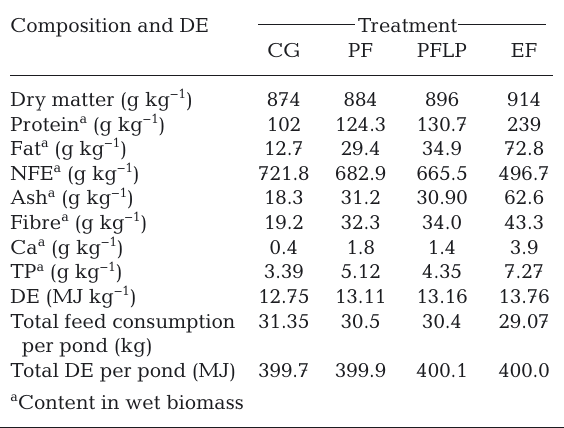
Table 1. Chemical composition and consumption rate of feeds provided in the experiments. CG: cereal grains; PF: pelleted feed; PFLP: pelleted feed with lowered phosphorus content; EF: extruded feed; NFE: nitrogen-free extract; Ca: